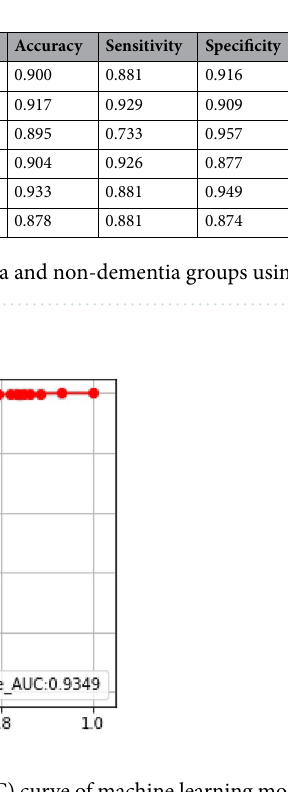
Figure 2. Receiver Operating Characteristic (ROC) curve of machine learning model.